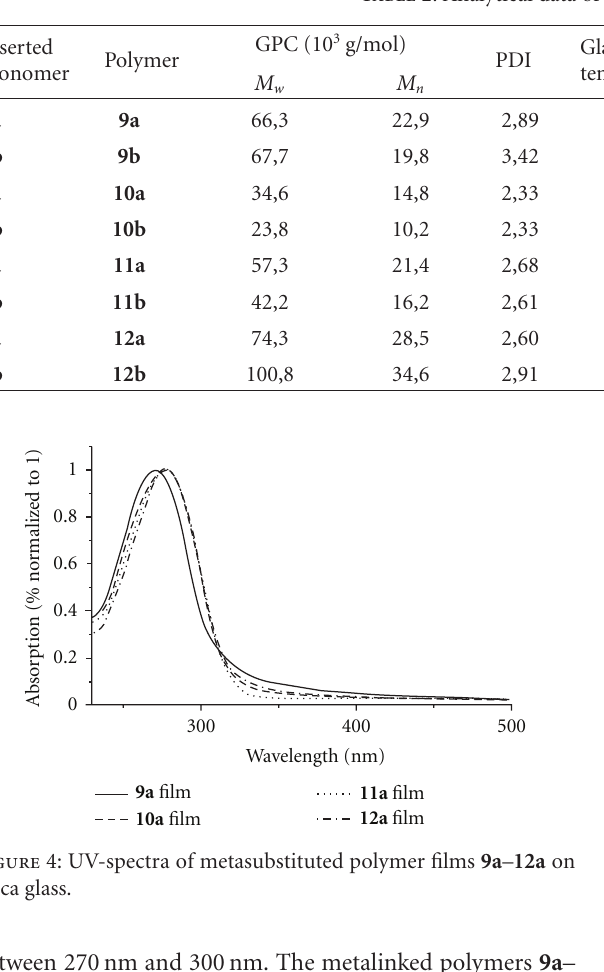
Table 2: Analytical data of the synthesized polymers.